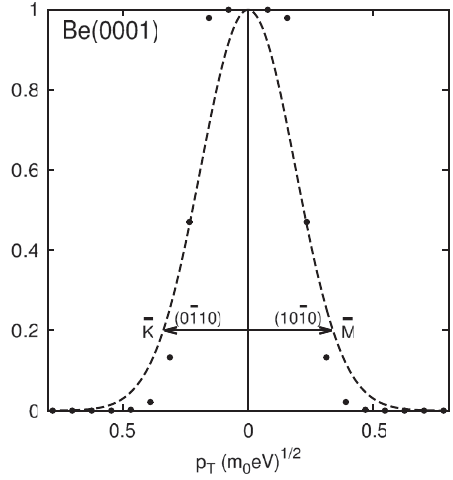
FIG. 4. Evaluated transverse electron momentum distributions (solid circles) in the M and K directions of the surface Brillouin 10¯10 01¯10 zone [the bulk ( ) and ( ) directions] for photoemission from the Be(0001) surface state with ℏ ω ¼ 8 . 74 eV. [Gaussian fit is guide to the eye (dashed